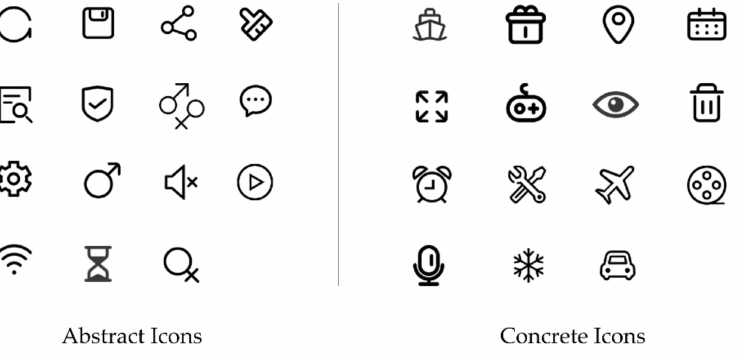
Figure 2. Icons used in the